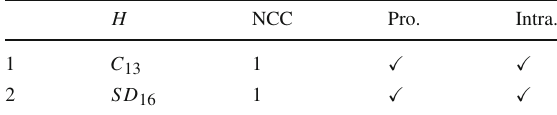
Table 10 The π -submaximal subgroups of S = L 3 ( 3 ) . Case: